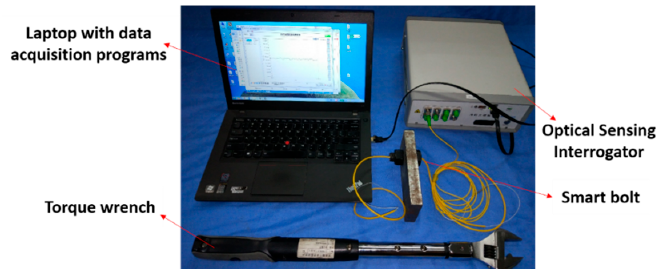
Figure 7. Experimental setup of external torque and bolt tension relationship verification.